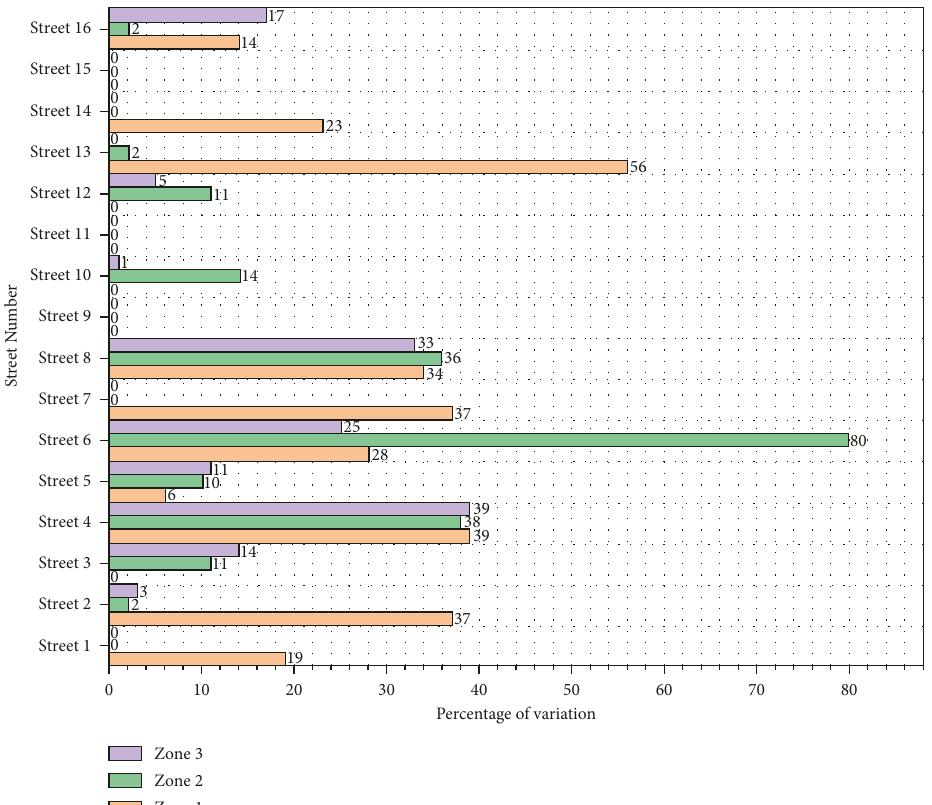
Figure 13: Percentage of variation between effective width ESVI values for collapse type 2 for investigated roads at different seismic intensities.